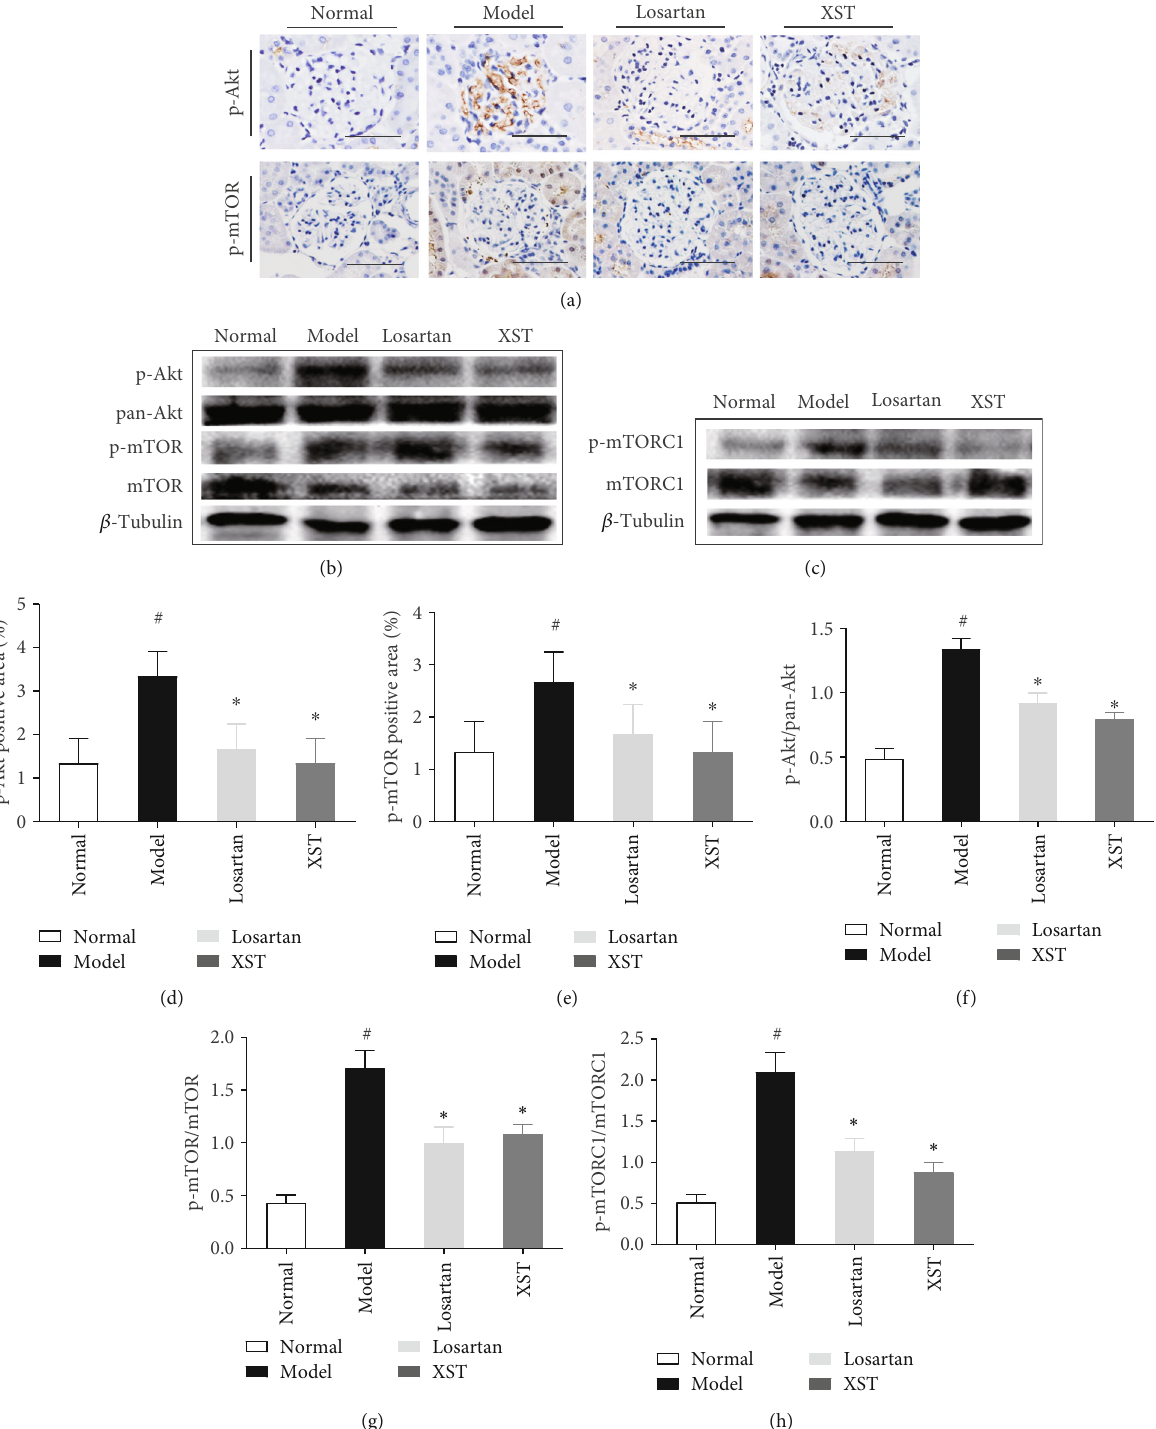
Figure 5: E ff ects of XST on p-Akt, p-mTOR, and p-mTORC1 expression in diabetic kidneys. Representative immunohistochemical staining (a) and western blotting (b, c) for p-Akt, p-mTOR, and p-mTORC1 in glomerulus. Quantitative analysis for p-Akt, p-mTOR, and p- mTORC1 (d – h). Scale bar = 100 μ m. Results were expressed as the means ± SEM . # P < 0 : 05 vs. normal; ∗ P < 0 : 05 vs.